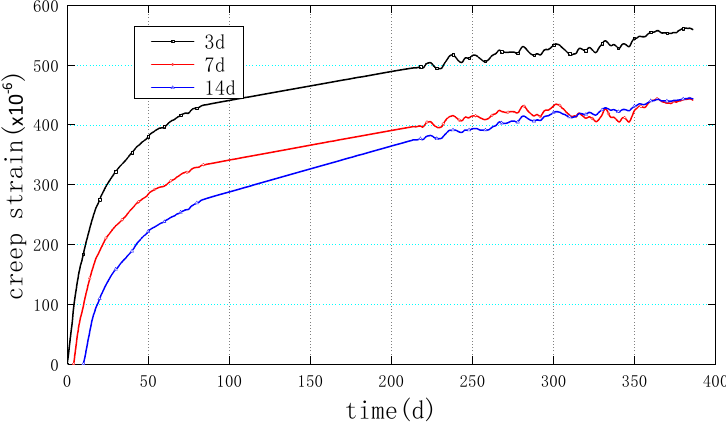
Figure 8. Time ‐ history plots of the creep strain for three loading ages and the load level of 40%.